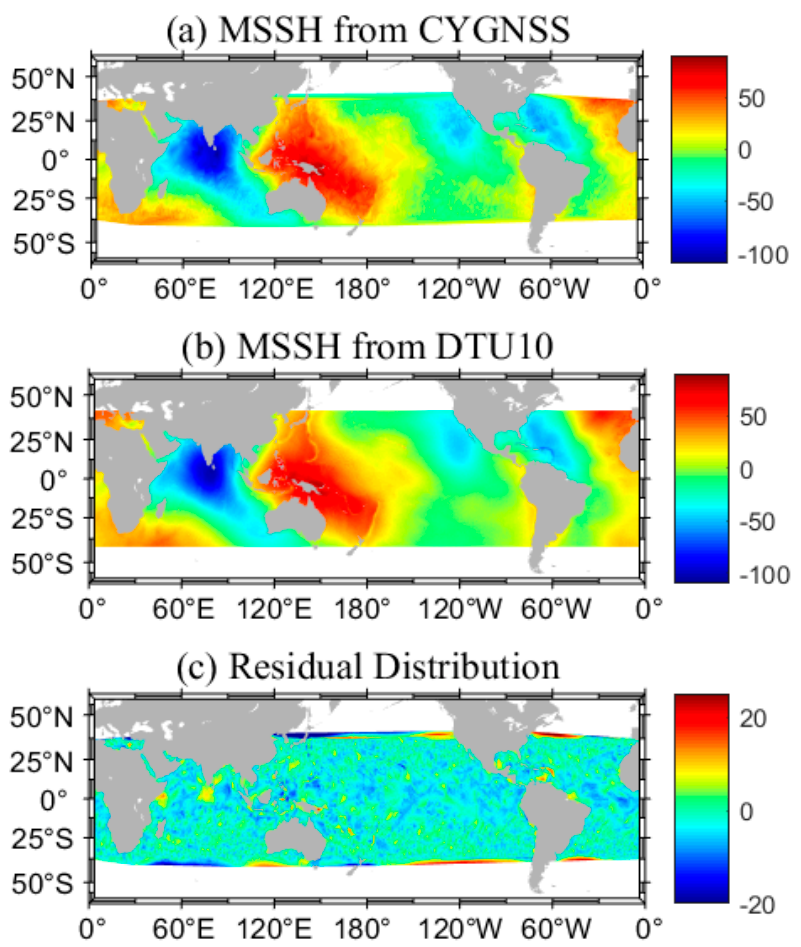
Figure 7. ( a ) Global mean sea surface height estimated by CYGNSS; ( b ) global mean sea surface height obtained by DTU10 model; ( c ) the residual between CYGNSS and DTU10.